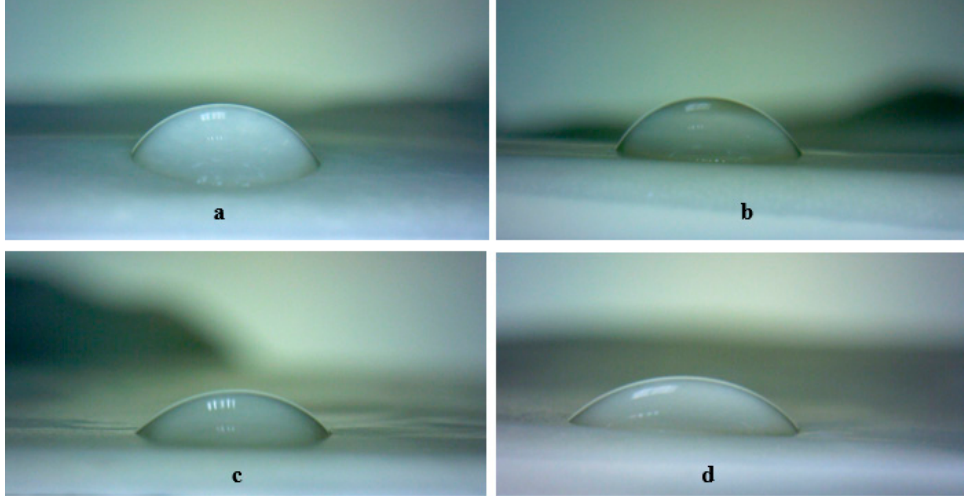
Figure 15. Water droplet profiles on NaOH treated rubber crumbs surface: ( a ) 1%, ( b ) 4%, ( c ) 7%, and ( d ) 10%.